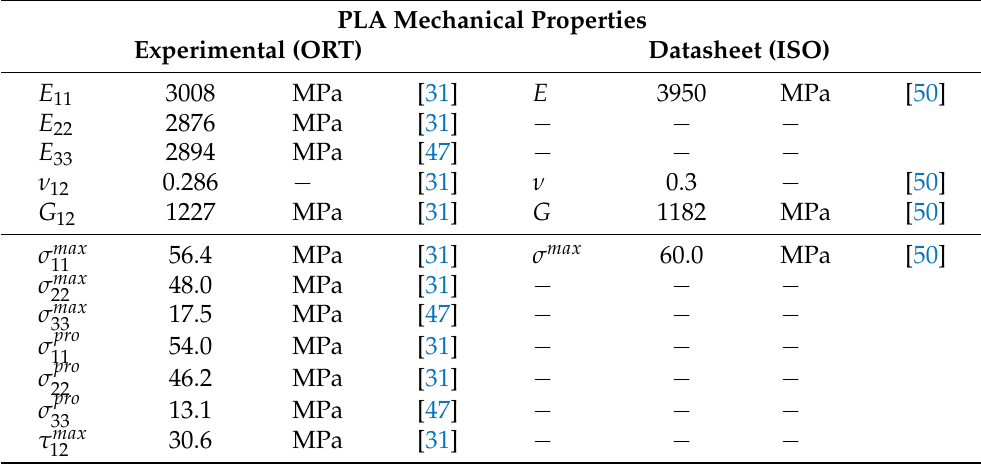
Table 5. Comparison between the experimental mechanical properties under the hypothesis of orthotropy and those declared by the manufacturer, assuming that PLA keeps isotropic behavior even after FFF processing.